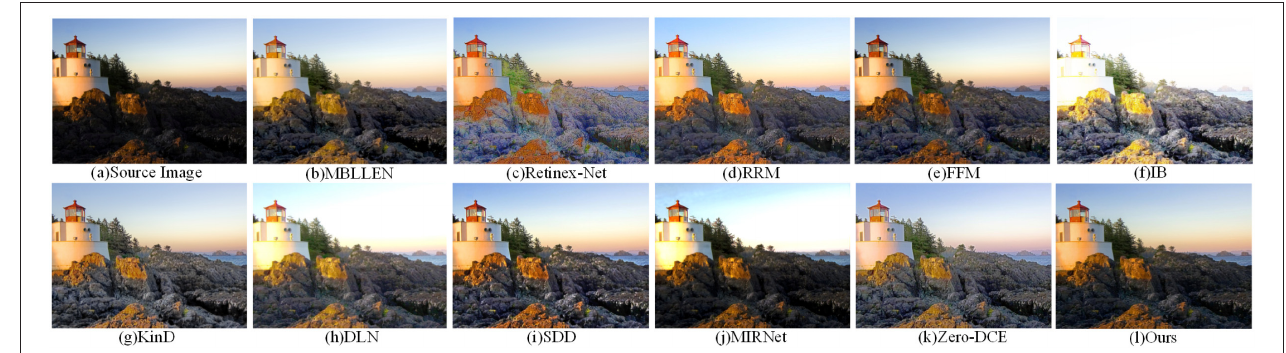
TABLE 1 | Comparison of the real low-light dataset in Figure 6 with the state-of-the-art low-light enhancement methods in metrics PSNR, SSIM, NIQE, BRISQUE, LOE.